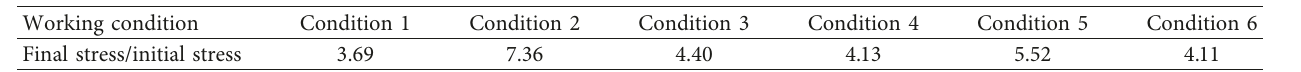
Figure 9: Surrounding rock stress variation of different excavation methods under WSS grouting reinforcement forms (a and b represent the CRD-4 method and DSDM method, respectively). Stress variation of the (a) first excavation, (b) second excavation, and (c) third excavation on different sections. Table 5: Stress release of surrounding rock under different construction